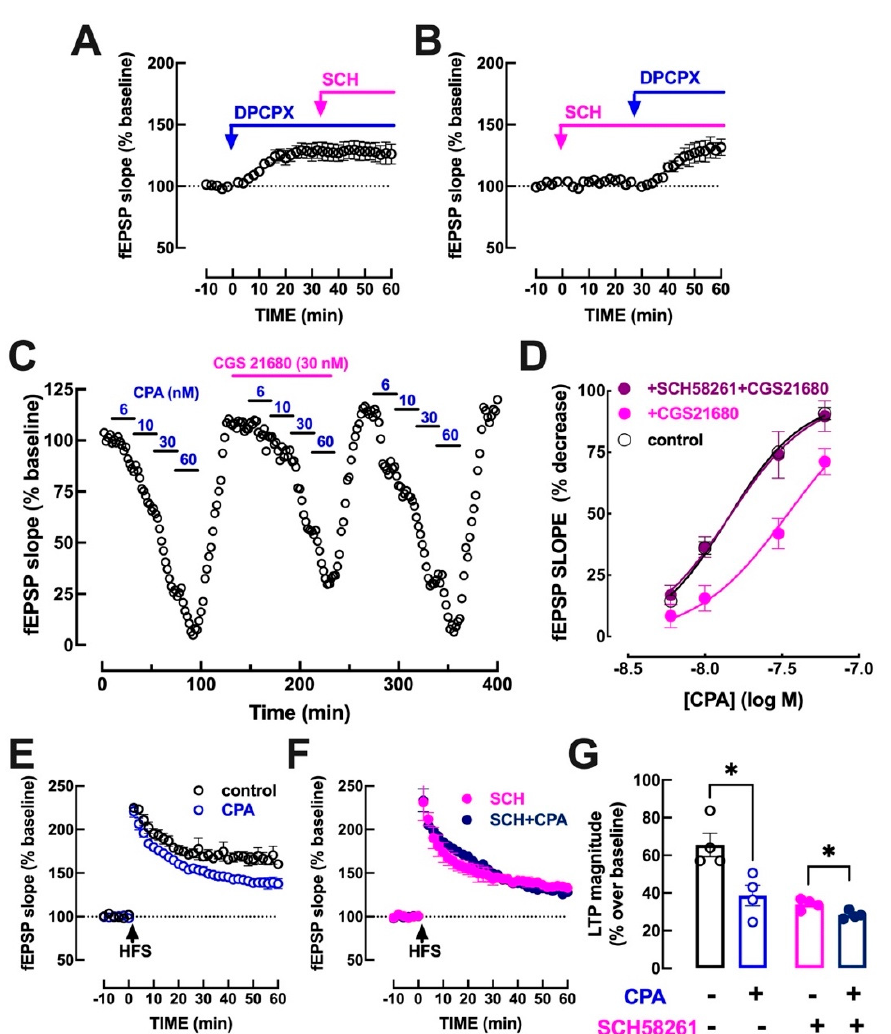
Figure 3. The activation of A 2A R attenuates the ability of A 1 R to control hippocampal synaptic transmission. ( A , B ) A supramaximal concentration of the A 1 R antagonist DPCPX (50 nM) increased basal hippocampal synaptic transmission measured as field excitatory postsynaptic potentials (fEPSP) in Schaffer fibers-CA1 pyramid synapses of mouse hippocampal slices, irrespective of the blockade of A 2A R with the selective antagonist SCH58261 (50 nM). ( C ) The A 2A R agonist, CGS21680 (30 nM), attenuated the ability of the selective A 1 R agonist, CPA (6–60 nM), to inhibit basal hippocampal synaptic transmission in a manner prevented by the A 2A R antagonist, SCH58261 (50 nM) ( D ). ( E ) CPA (30 nM) inhibited hippocampal long-term potentiation (LTP) in CA1 synapses triggered by high-frequency stimulation train (HFS: one train of 100 pulses at 100 Hz), an inhibitory effect still present but attenuated by blocking A 2A R with SCH58261 (50 nM) ( F ), as quantified in ( G ). * p < 0.01, Student’s t test.